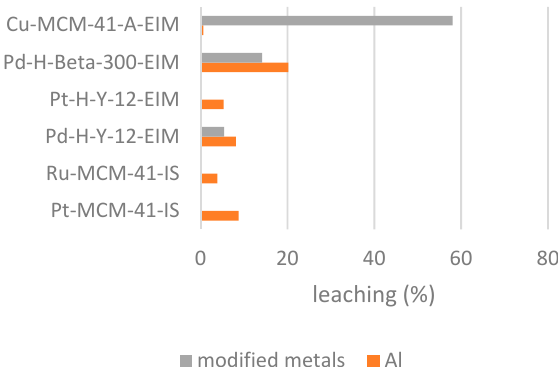
Figure 13. Leaching of modified metal and aluminum (%) in the catalytic ozonation of CBZ at 20 °C.